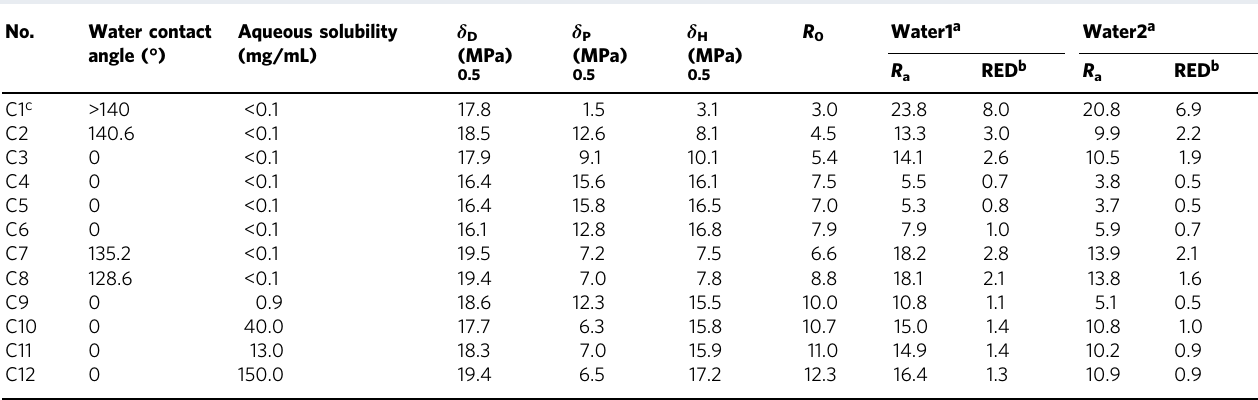
Fig. 1 The evolution of N/O doping from simplicity to complexity. a Aqueous solubility of simply common aromatic hydrocarbons and their corresponding N/O doping analogs at 25 °C (data in parentheses was obtained from hazardous substances data bank). b Molecular structure design via diversi fi ed aromatic polycycles fusion. c Combination of programmed N/O doping towards pristine C1 structure (highlighted molecules demonstrate excellent aqueous solubility). Table 1 Solubility-related parameters of C1 –